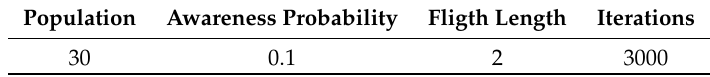
Table 3. Crow Search Algorithm (CSA) Parameters for Set Covering Problem (SCP) and Knapsack Problem (KP)—Two-steps.